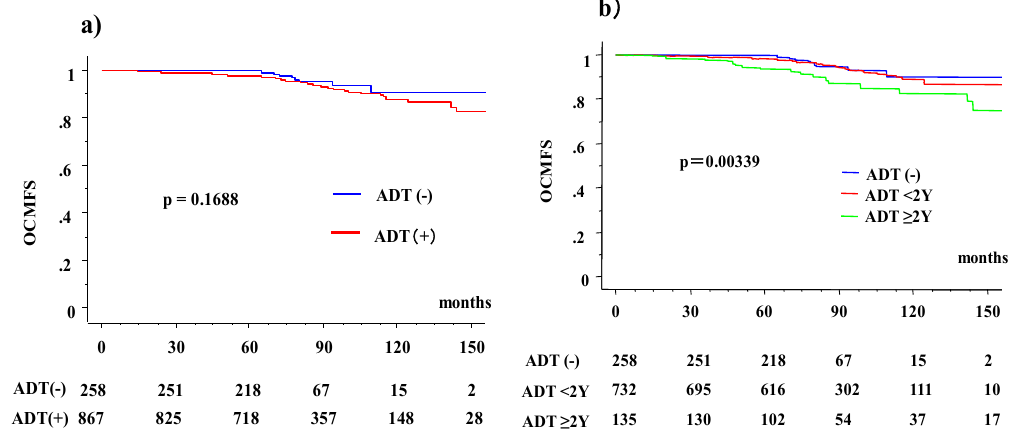
Figure 1. Other cause of mortality (OCM) with or without androgen deprivation therapy (ADT). ( a ) OCM according to ADT (+) and ( − ) in total population. ( b ) OCM according to three ADT groups divided by duration (ADT naïve, ADT <2 years and ADT ≥ 2 years). OCMFS = other cause of mortality (OCM) ‐ free survival rate.